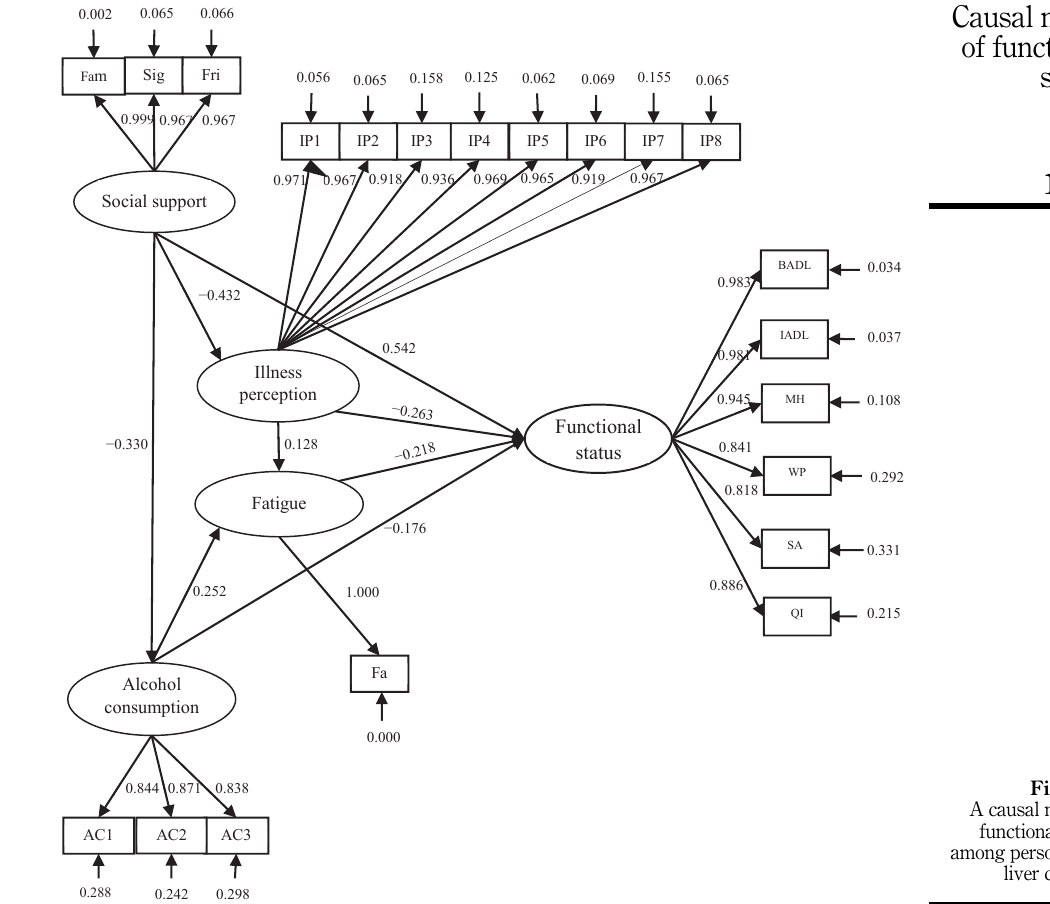
Figure 2. A causal model of functional status among persons